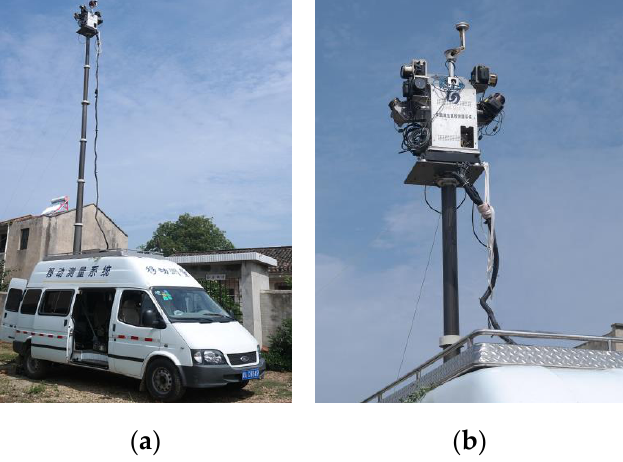
Figure 3. Stop-and-go mode laser scanning system: ( a ) a distance view; and ( b ) a close-up